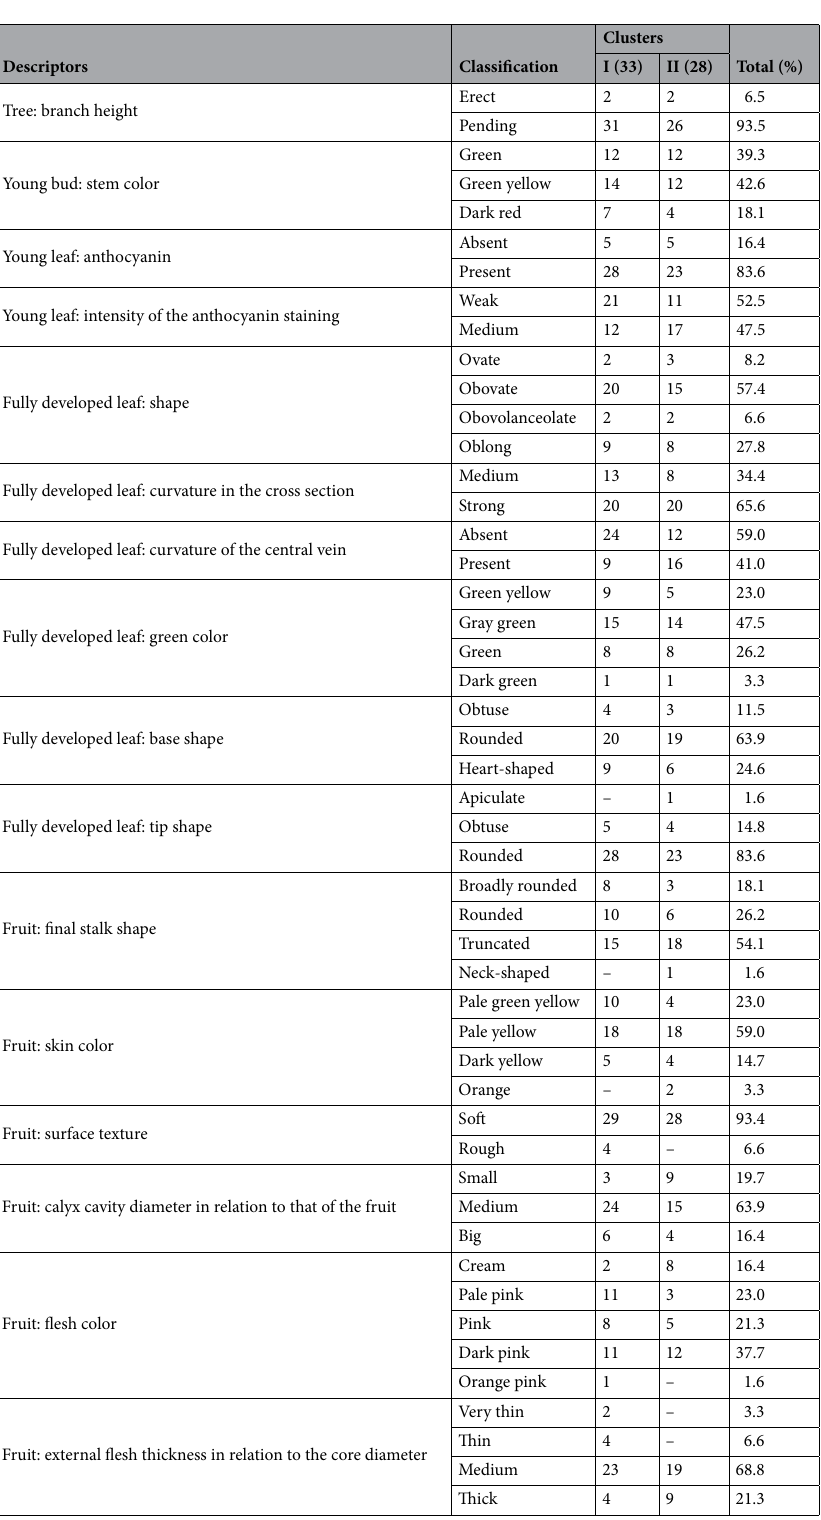
Table 3. Phenotypic classes of plant descriptors; leaf and fruit; and number of genotypes of S 1 inbred guava families per cluster formed by the Ward-MLM strategy. UENF, municipality of Campos dos Goytacazes,